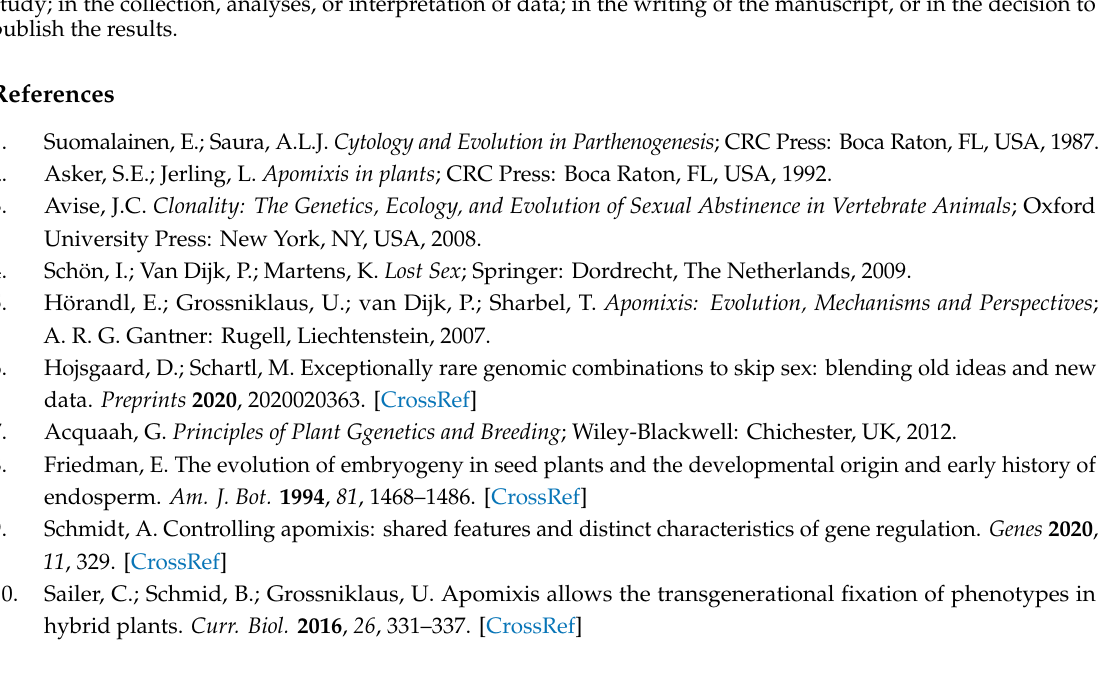
Table S1: List of sexual plant species belonging to apomictic-containing genera with public genomes assemblies available in